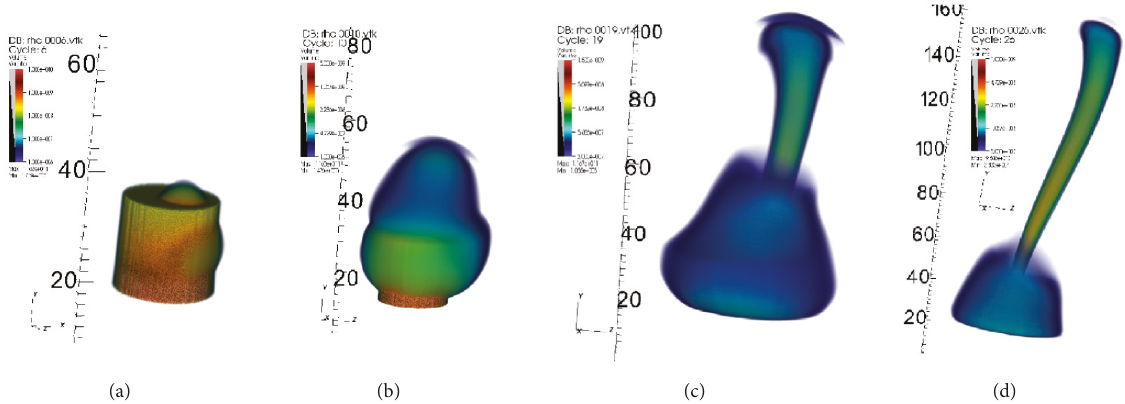
Figure 1: Scenario C: three-dimensional density snapshots obtained as in scenario A of [13], but now we added an accelerated precession of the jet that leads to the formation of a revolving jet flow. See the rightmost panel of Table 1, where the jet is the most evolved among the plots (parametersof run3, snapshot intervals50/count). The jet’s behaviourresembles to that of scenario A (run1) of [13]. Also, now the jet sweeps a larger volume of ambient matter and propagates slower than in the nonprecession case, though now more ambient matter is further activated for emission. Matter piles up around the jet base, hinting on a halo of slower moving (outbound) material there, crudely reminiscent of the suggestion of [14] for a halo formed around SS433.